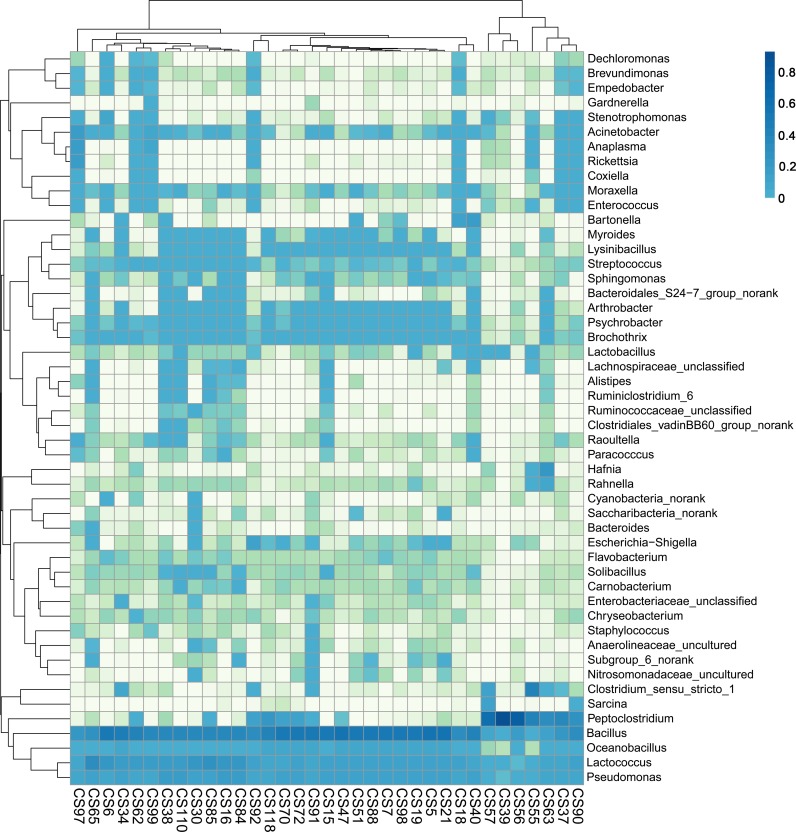
Heat map of spleen microbiota compositions at genus level.Log-scaled percentages of the abundances for the top 50 taxa at genus level in 35 mouse and shrew samples from Chongming Island, Shanghai city were illustrated in the heat map. The color scale (log10%) was on the left.